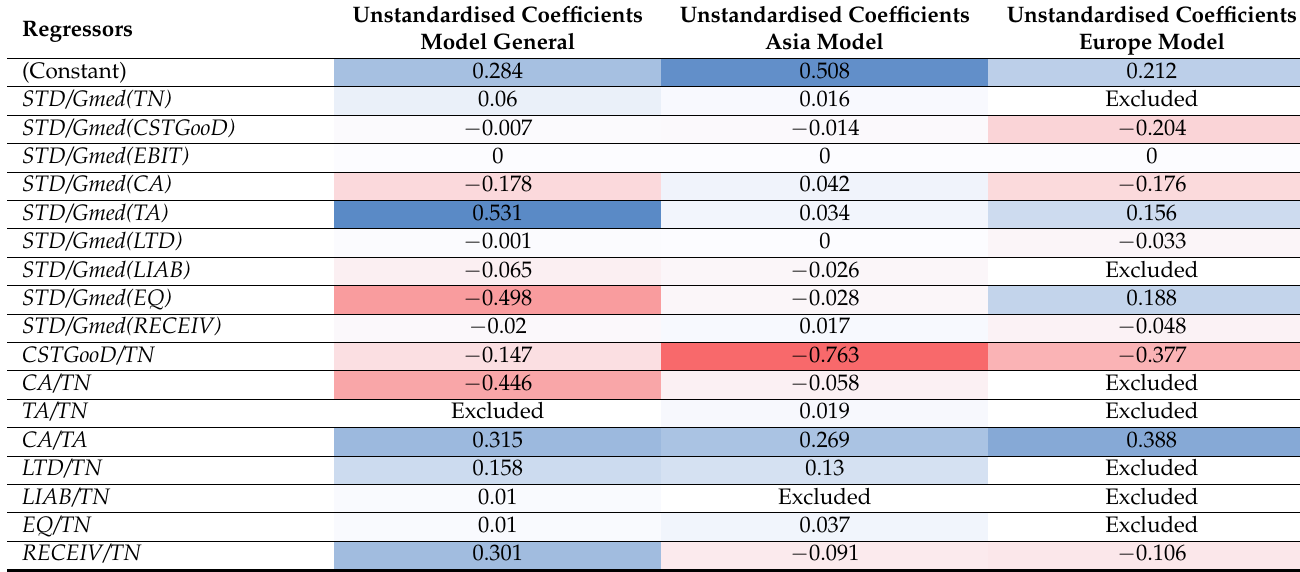
Table 4. Unstandardised Coefficients